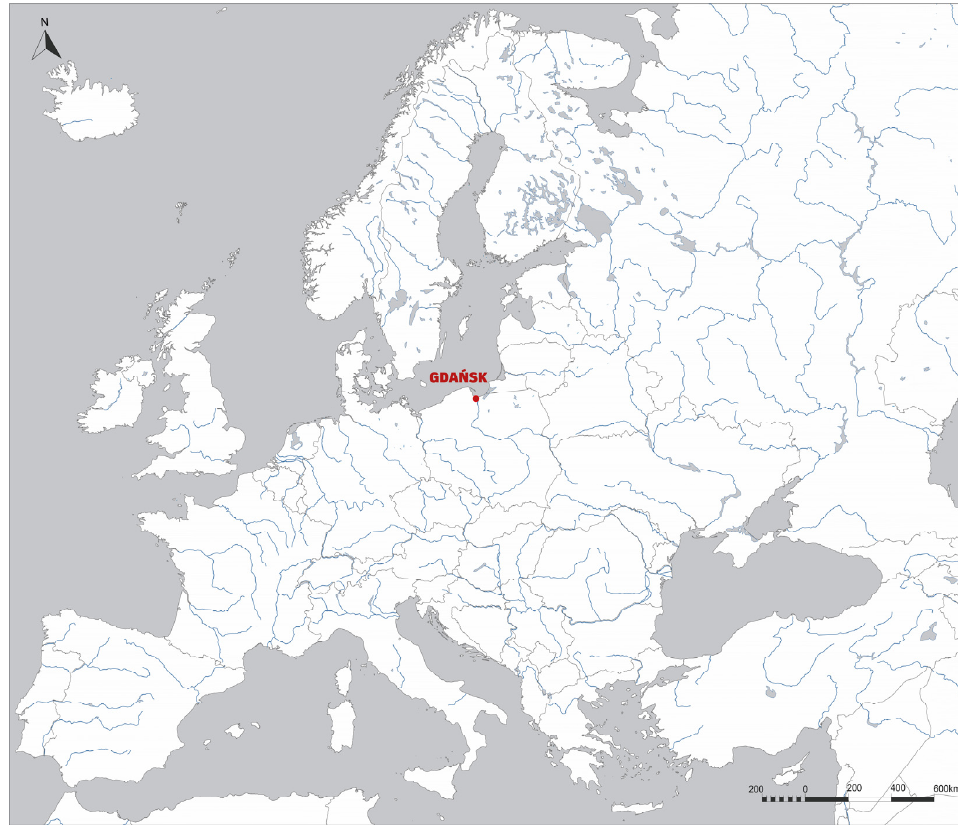
Figure 1. Location of the research topic: Gda ń sk as a historical port city at the mouth of the Vistula river.